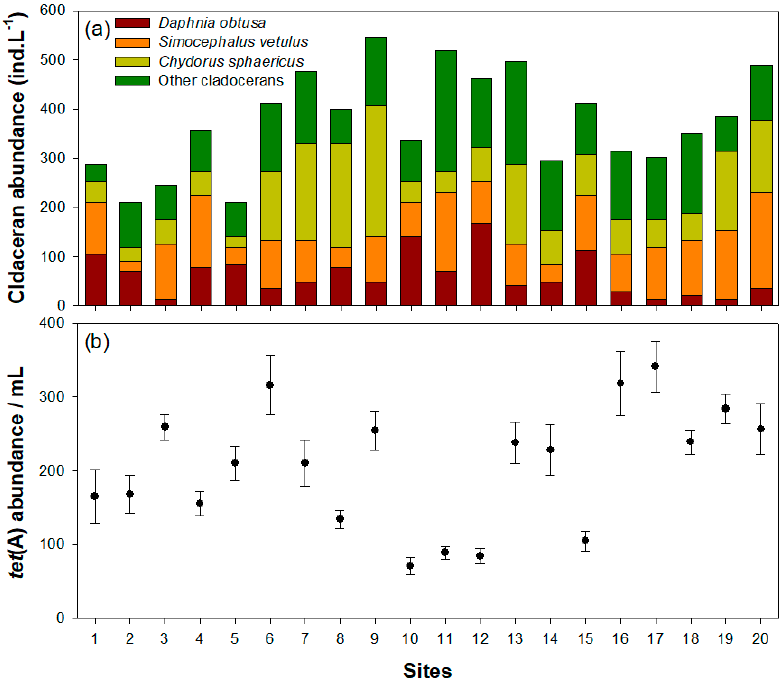
Figure 4. Cladoceran abundance and tet (A) abundance in 20 wetlands: ( a ) cladoceran abundance; ( b ) tet (A) abundance.